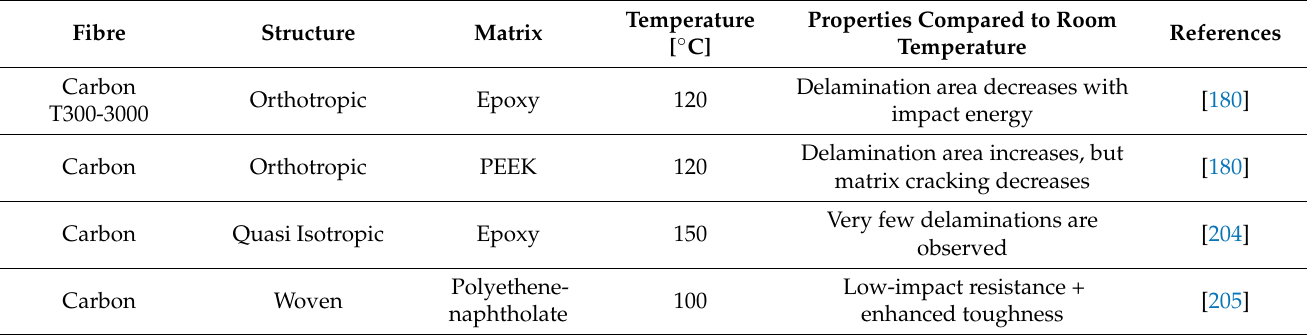
Table 8. Summary of the effect of high temperatures on impact behaviour of fibre-reinforced